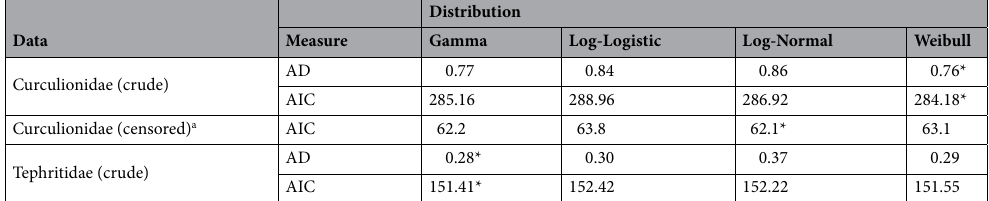
Table 2. Model Goodness-of-Fit Test Results. a Anderson-Darling statistic not computed for censored data. AD Anderson–Darling statistic, AIC Akaike’s information criterion. *Indicates the best fitting